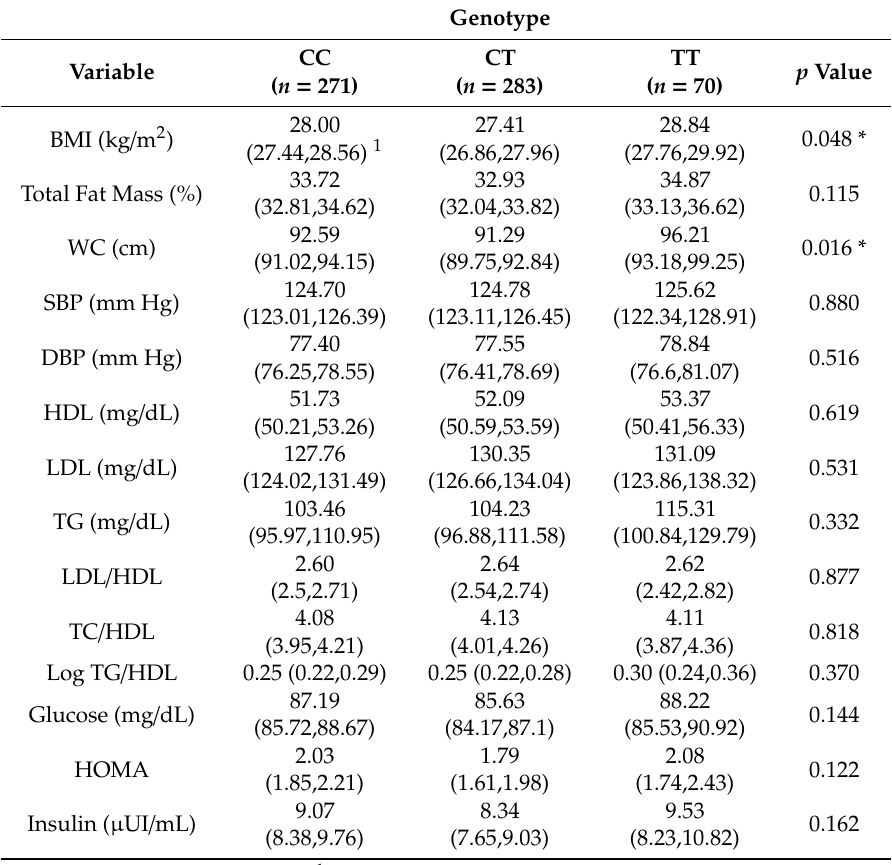
Table 1. Anthropometric and biochemical data by genotypes of the